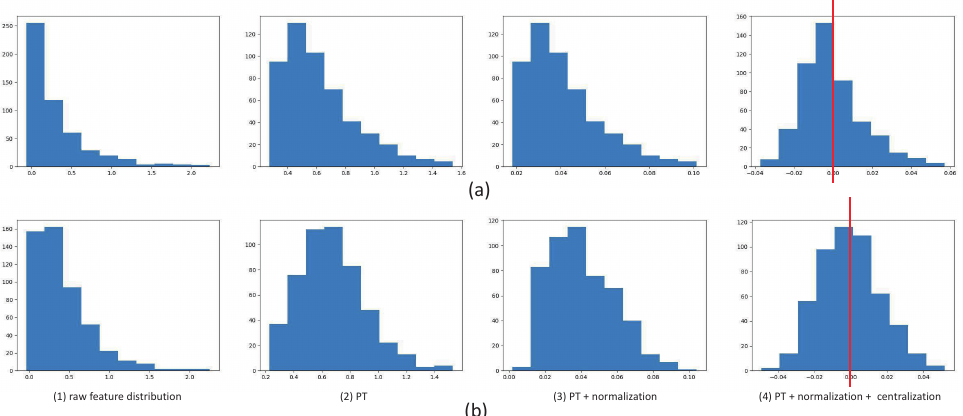
Figure 2. The histograms of each step in the GC module. The red line highlights the symmetry of the histogram when µ = 0. ( a ) A sample embedded in the spatial domain. ( b ) The same sample embedded in the frequency domain. The first column is the raw feature distribution, the second column is after PT, the third column is after PT + normalization, the fourth column is after PT + normalization +